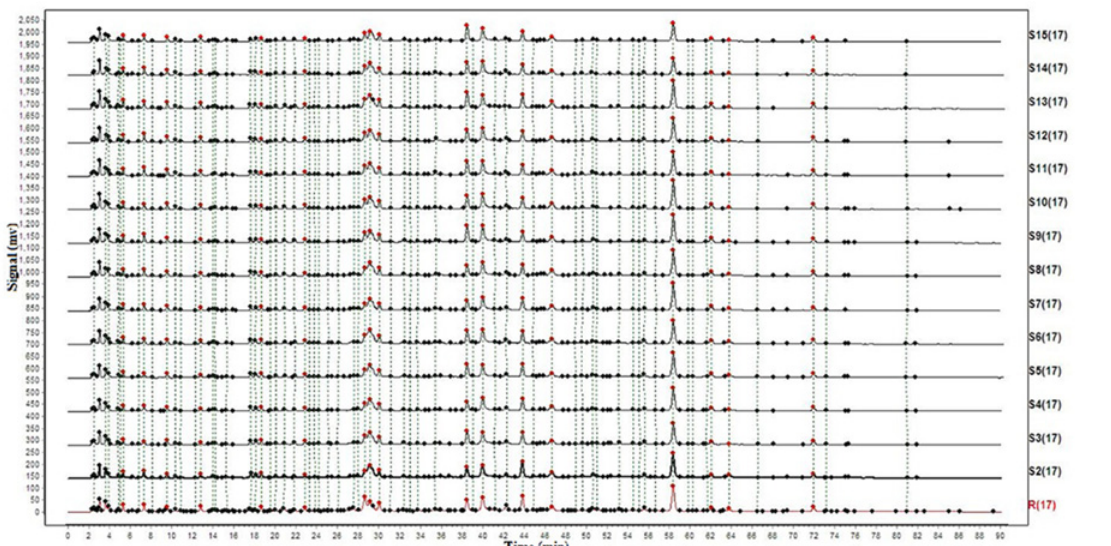
Fig 1. Fingerprint chromatograph of